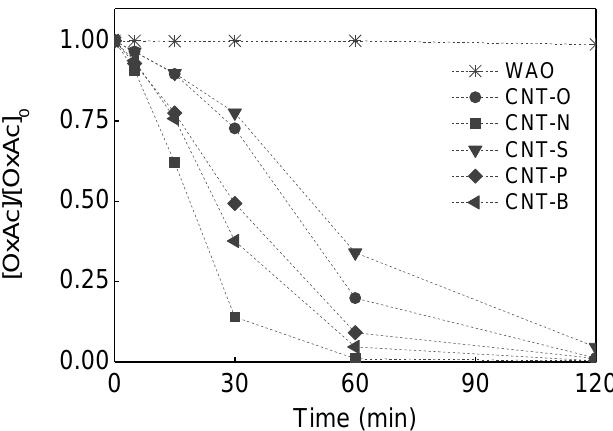
Figure 6. Evolution of normalized oxalic acid concentration at 140 ◦ C and 40 bar of total pressure under non-catalytic conditions (WAO) and using doped carbon nanotube samples in catalytic wet air oxidation (CWAO).